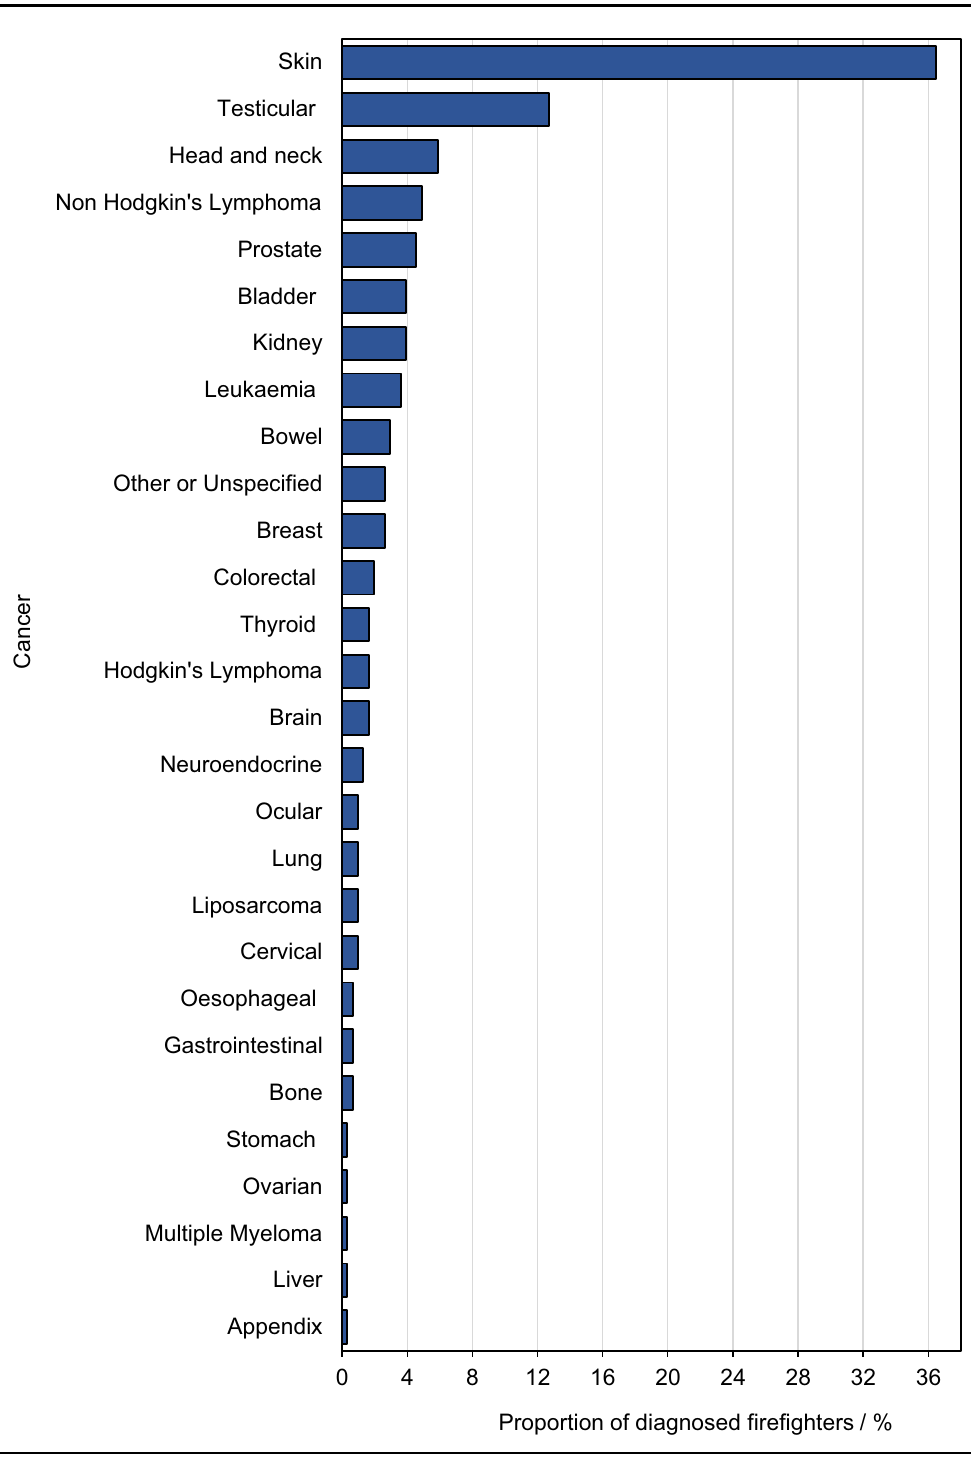
Figure 1. Range and frequency of cancers among diagnosed firefighters in the UK Fire and Rescue Service. Prevalence of specific cancers among firefighters who received a diagnosis after joining the Fire and Rescue Service (i.e. a % of 307). Cancers were reported as free text and manually coded for